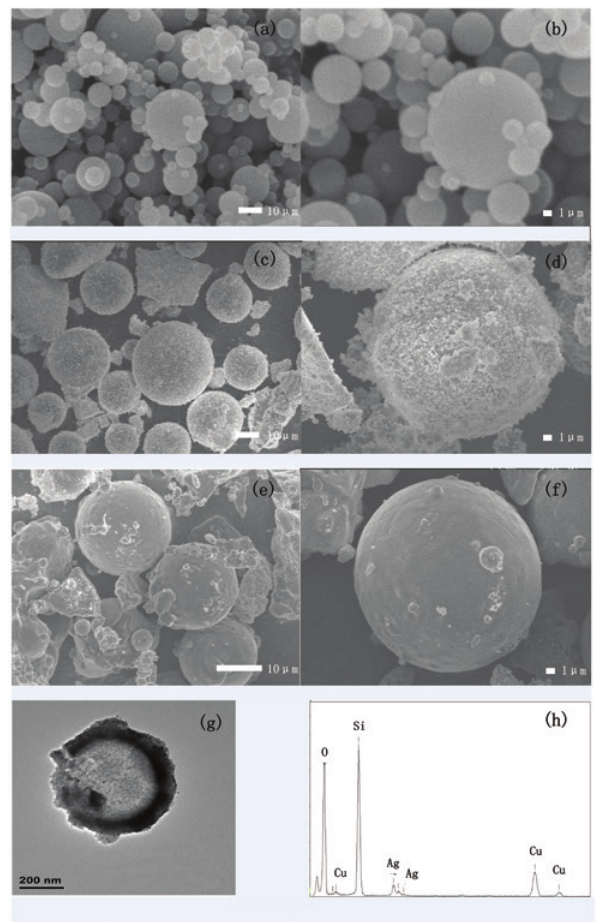
/Ag 2 /Ag composite 2